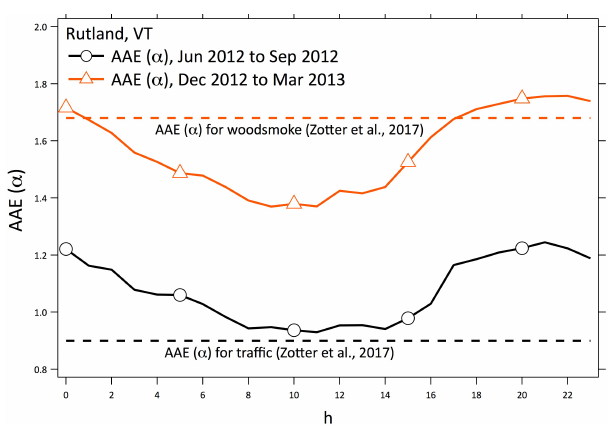
Figure 5. Diurnal profiles of absorption Ångström exponents (AAE) derived from the two-wavelength Aethalometer data mea- sured at the Rutland site from October 2011 to June 2013. The rec- ommended AAE values for traffic and woodsmoke, respectively, by Zotter et al. (2017) are also